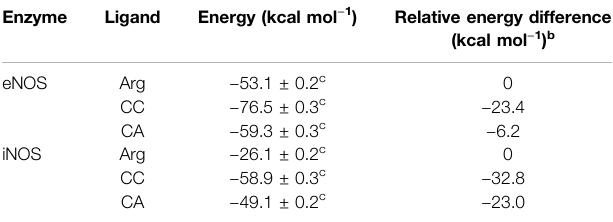
TABLE 1 | Calculated Binding Free Energies using MM/PBSA a